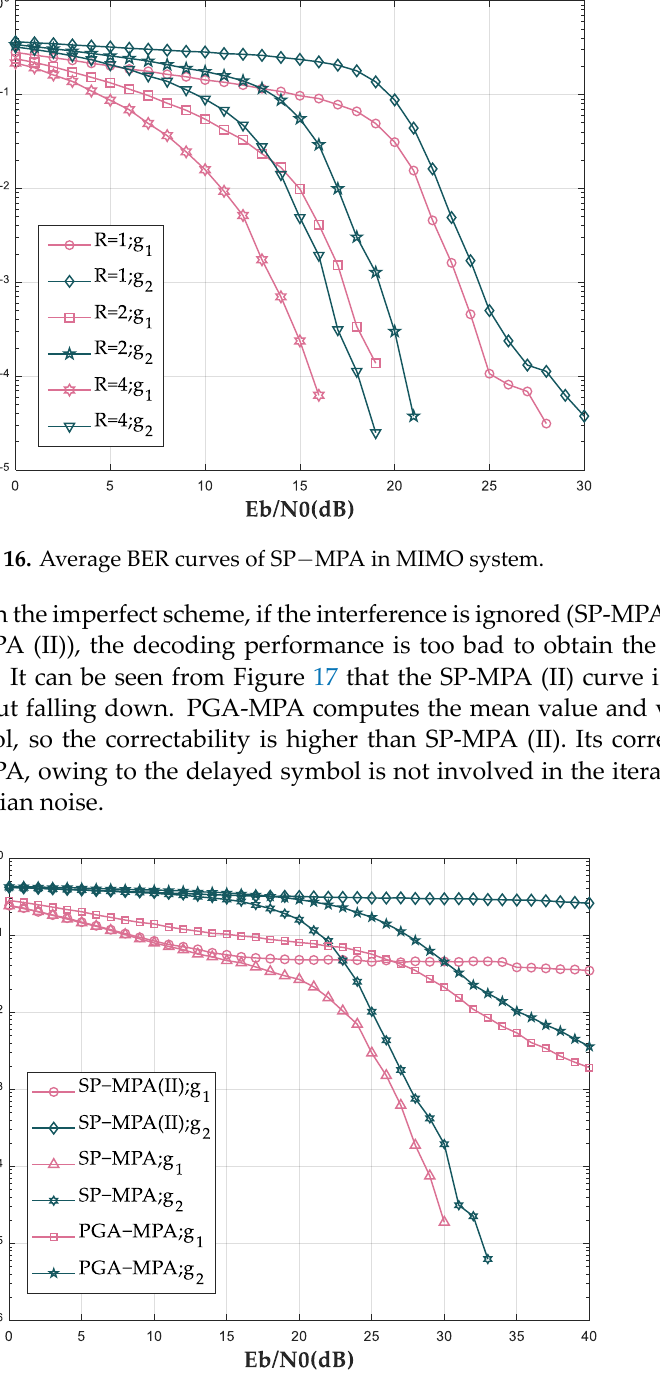
Figure 17. Average BER curves in imperfect